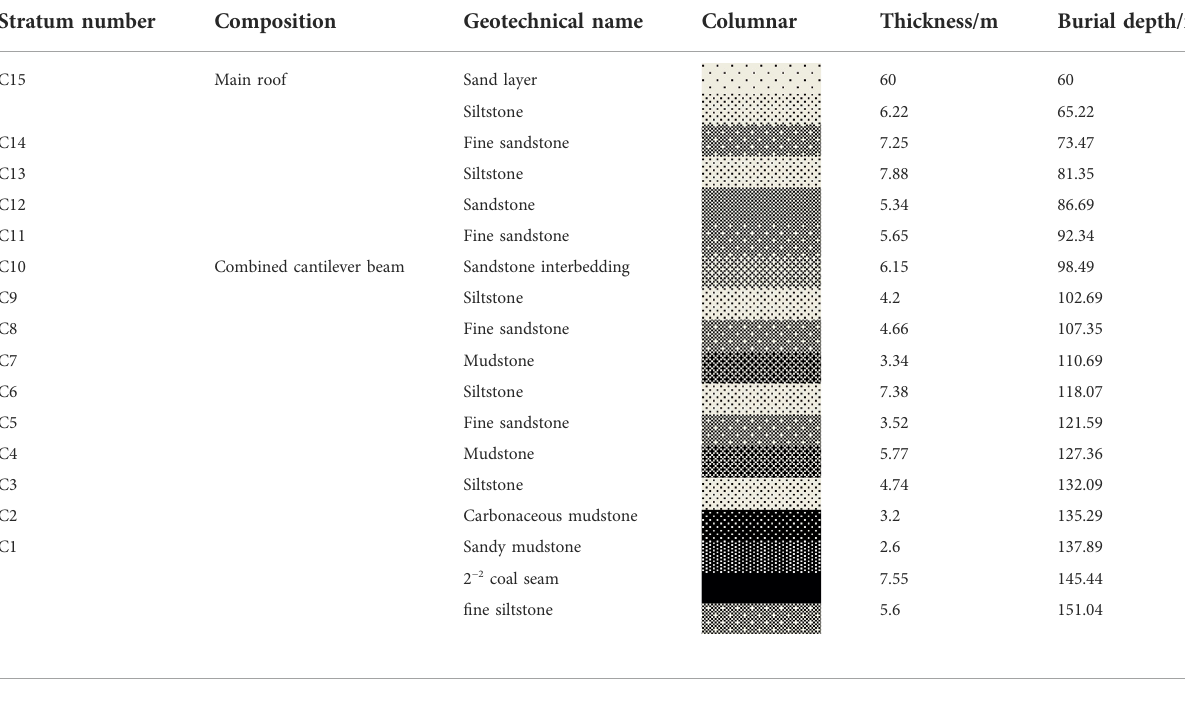
TABLE 2 The weighing characteristic of no.63 support. Times of